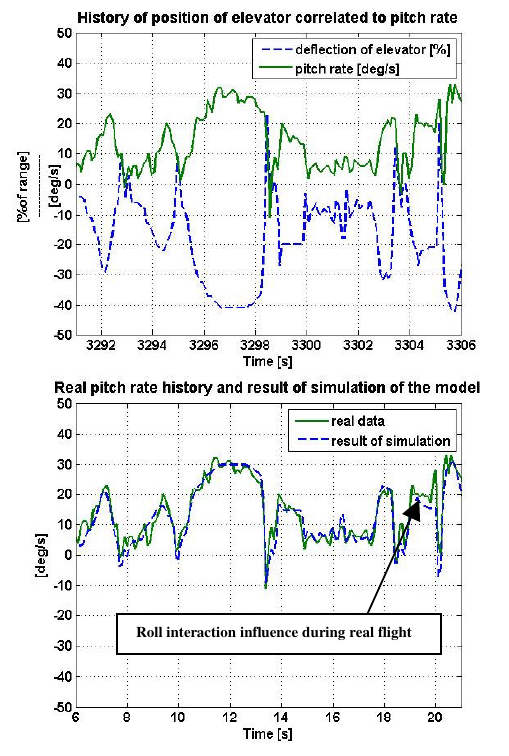
Fig 6. The history of deflection of ailerons and pitch rate (upper); real data and results of simulation of the model